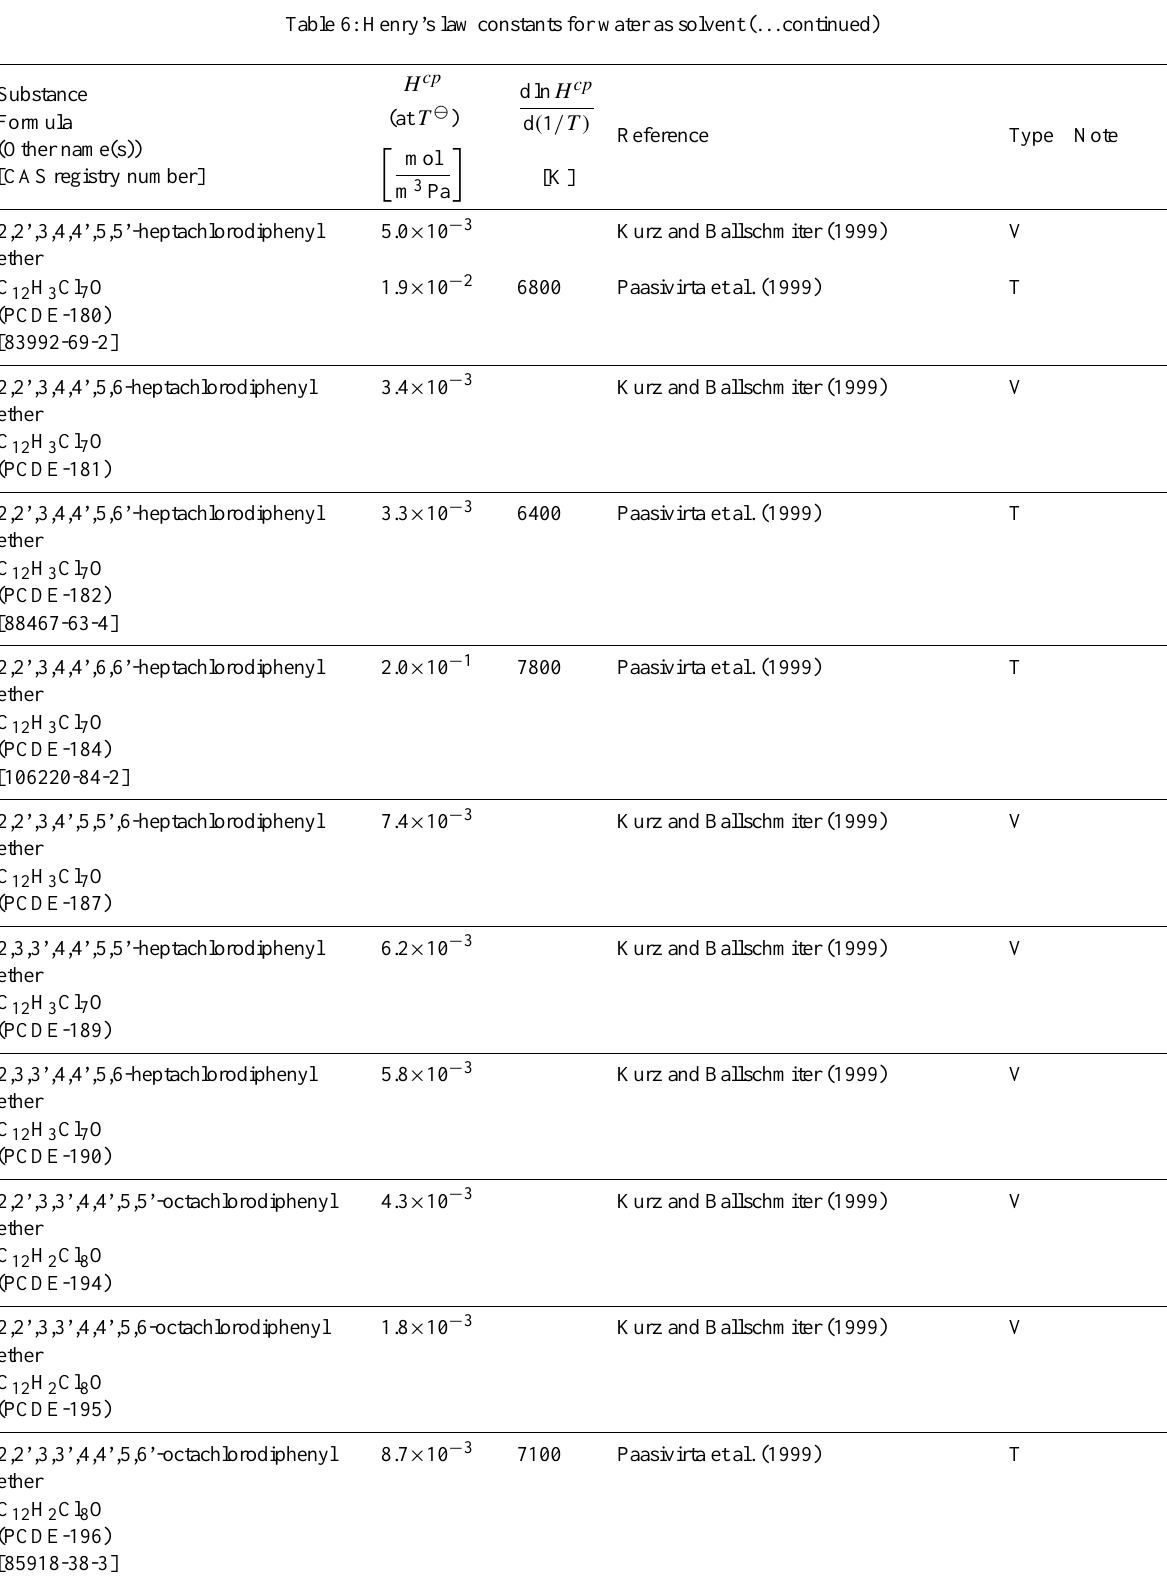
Table 6: Henry’s law constants for water as solvent